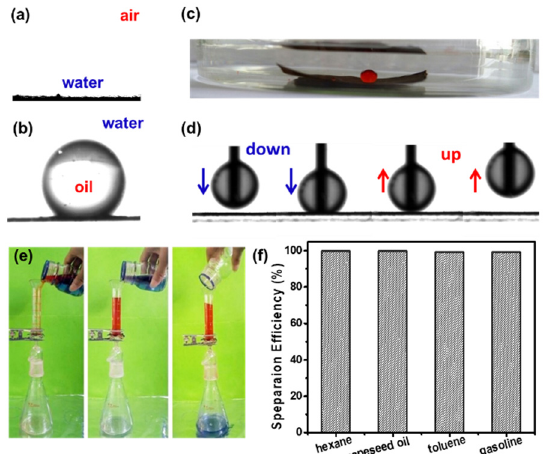
Figure 4. ( a , b ) The wetting behavior of the as-prepared mesh towards water in air and oil in water. ( c ) Photograph of the oil droplet on the coated mesh in water. ( d ) Photographs of the dynamic underwater oil-adhesion measurements on the coated mesh. ( e ) Photographs of the mixture of hexane and water being poured into the upper glass tube and separating well. ( f ) The separation efficiency of the mesh for different kinds of oils mixed water.